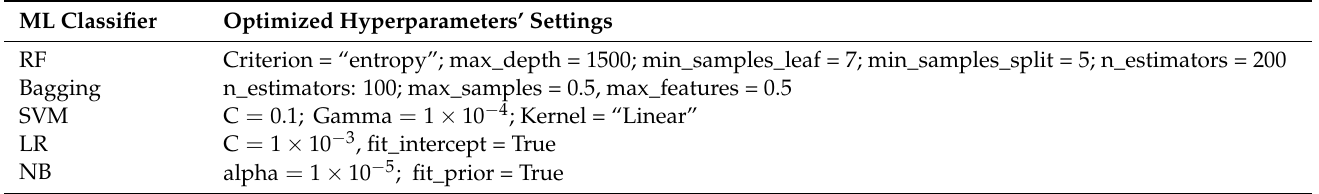
Table 9. The optimized hyperparameters’